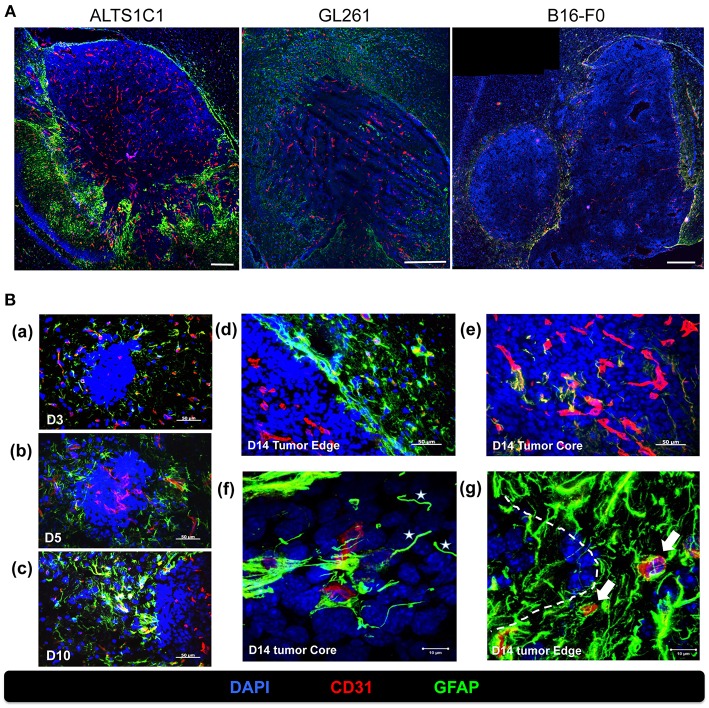
Activated astrocytes surrounded the tumor border during tumor progression. (A) The correlation of vasculatures and astrocytes pattern was examined in orthotopic tumors, including astrocytoma ALTS1C1, glioma GL261, and melanoma B16-F0 tumors. Brain tumor tissues were double stained with GFAP (green) and CD31 (red). Scale bar = 400 μm. (B) Mice were sacrificed on day 3 (a), day 5 (b), day 10(c), and day 14 (d,e) after I.C. inoculation of ALTS1C1 brain tumor. Tumor sections were double staining for GFAP (green) and CD31 (red). Nucleus was stained with DAPI (blue). Scale bar = 50 μm. (f,g) Representative images at day 14 captured by confocal microscope. White stars marked vessel-like astrocytes (f) and white arrows indicated activated astrocyte-attached vessels (g). Tumor boundary was outlined by white dotted line. Scale bar = 10 μm.